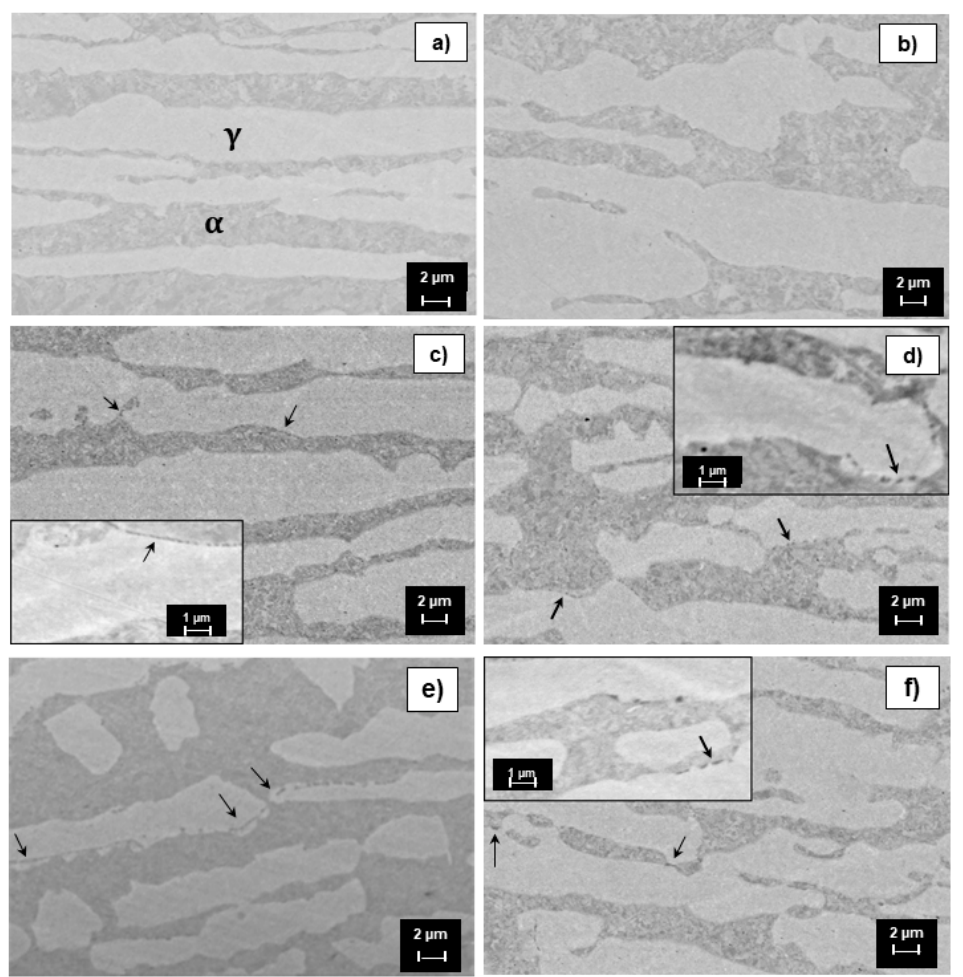
Figure 1. SEM-BSD micrographs of both duplex stainless steel (DSS) 2304 as-received ( a ) and aged for: 5 ( b ) and 60 min ( c ) at 650 °C, 10 ( d ) and 60 min ( e ) at 750 °C and 60 min at 850 °C ( f ).